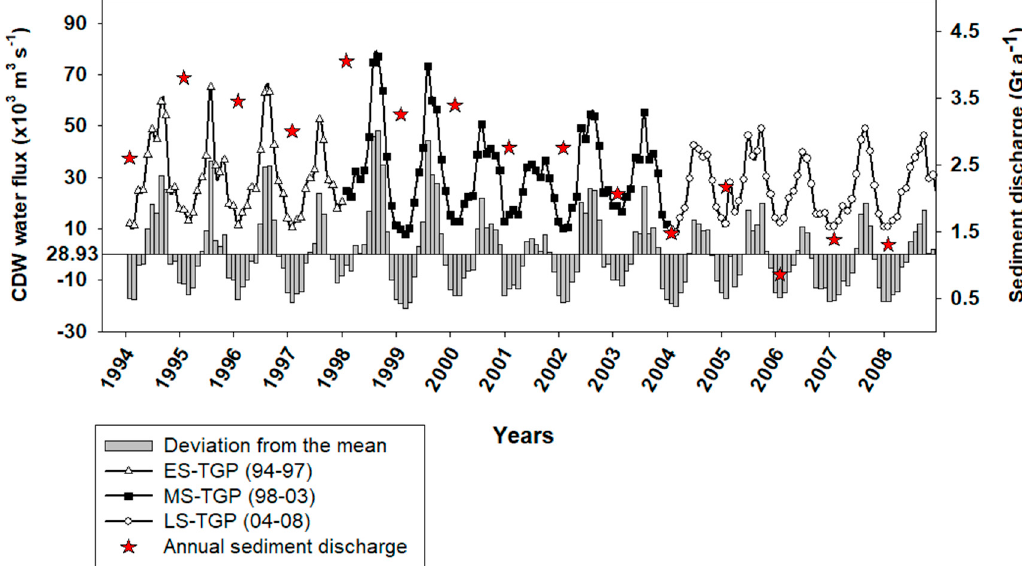
Figure 4. Monthly values of CDW flux and sediment discharge during the three TGP construction periods. The triangular, square, and rounded lines represent water flux in the ES-TGP, MS-TGP, and LS-TGP, respectively. Histogram represents deviation values from the mean diluted water flux during the whole TGP period. The red star represents the annual sediment discharge to the Changjiang Estuary. The data were obtained from the Datong hydrological